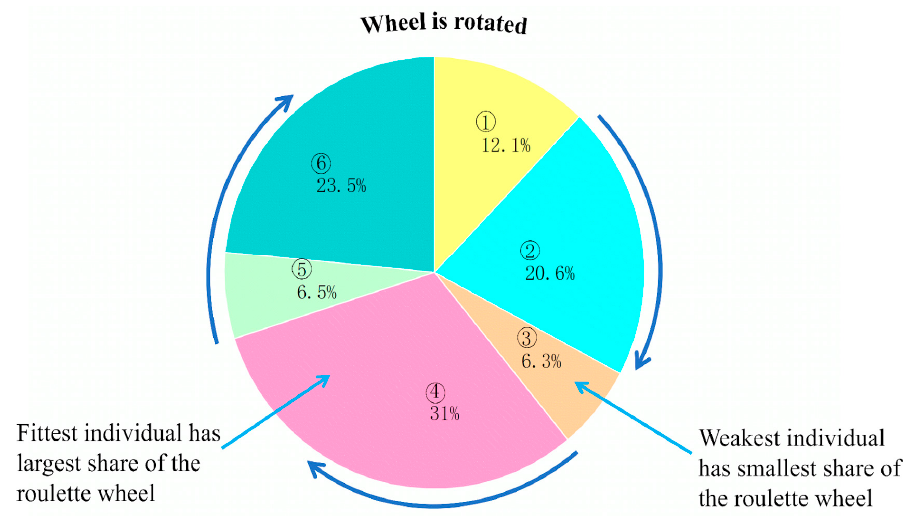
Figure 1. Schematic diagram of roulette.